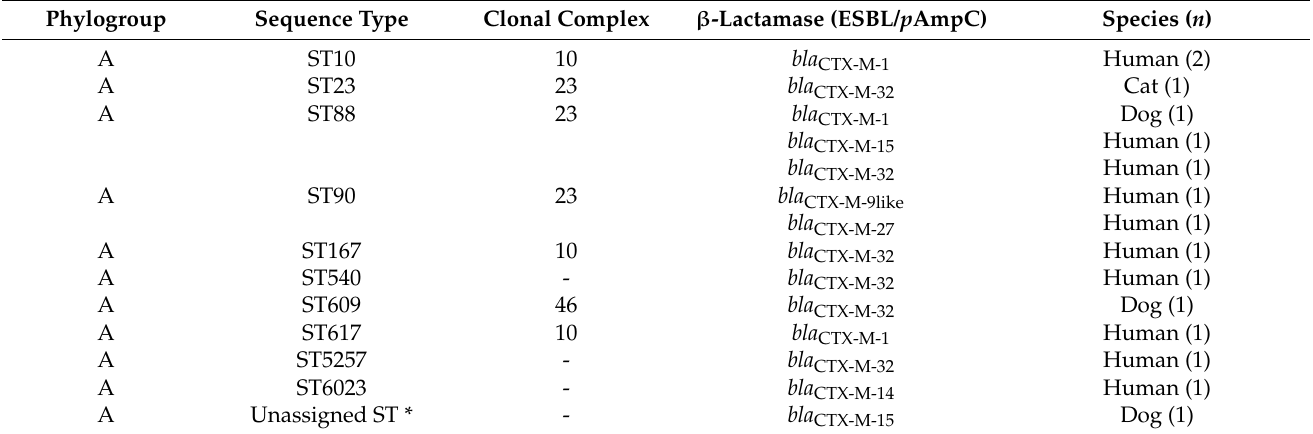
Table 7. Sequence types of ESBLs/ p AmpC-producing E. coli isolated from companion animals and humans with